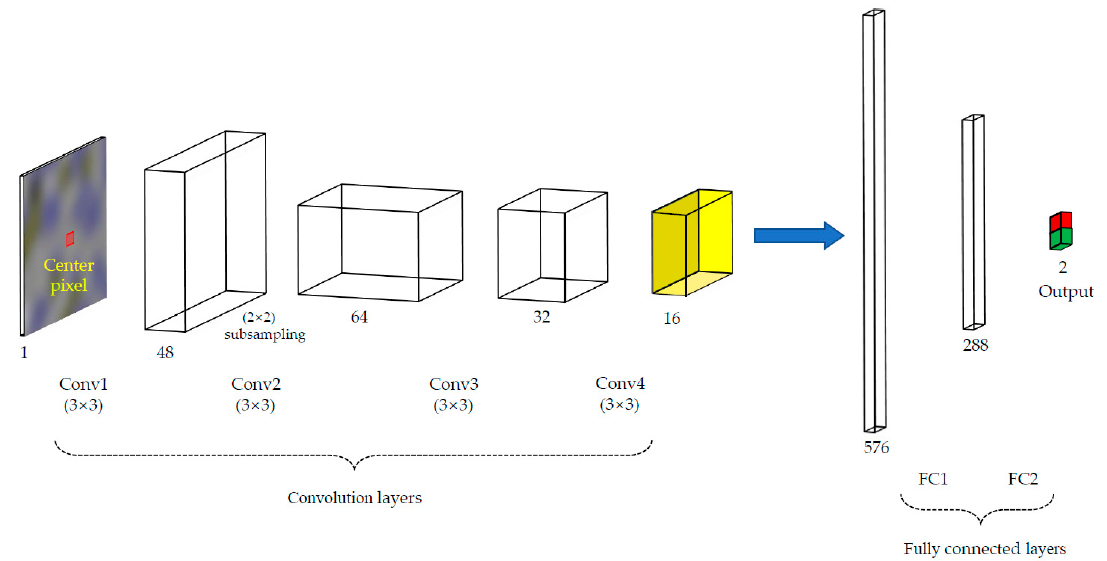
Figure 5. Convolutional neural network (CNN) architecture. “Conv” and “FC” indicate convolutional layers and fully connected layers ,